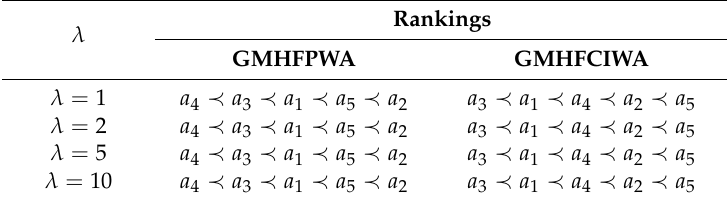
Table 3. Rankings obtained using the GMHFPWA and the GMHFCIWA operators.